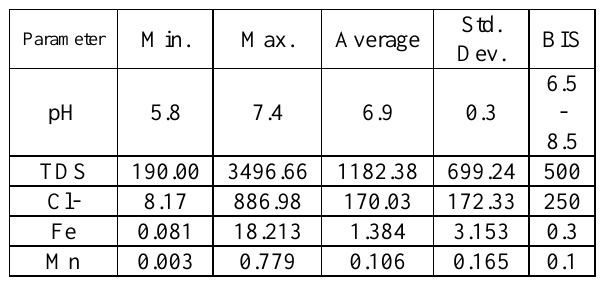
Table 2. Basic parameters for collected water samples